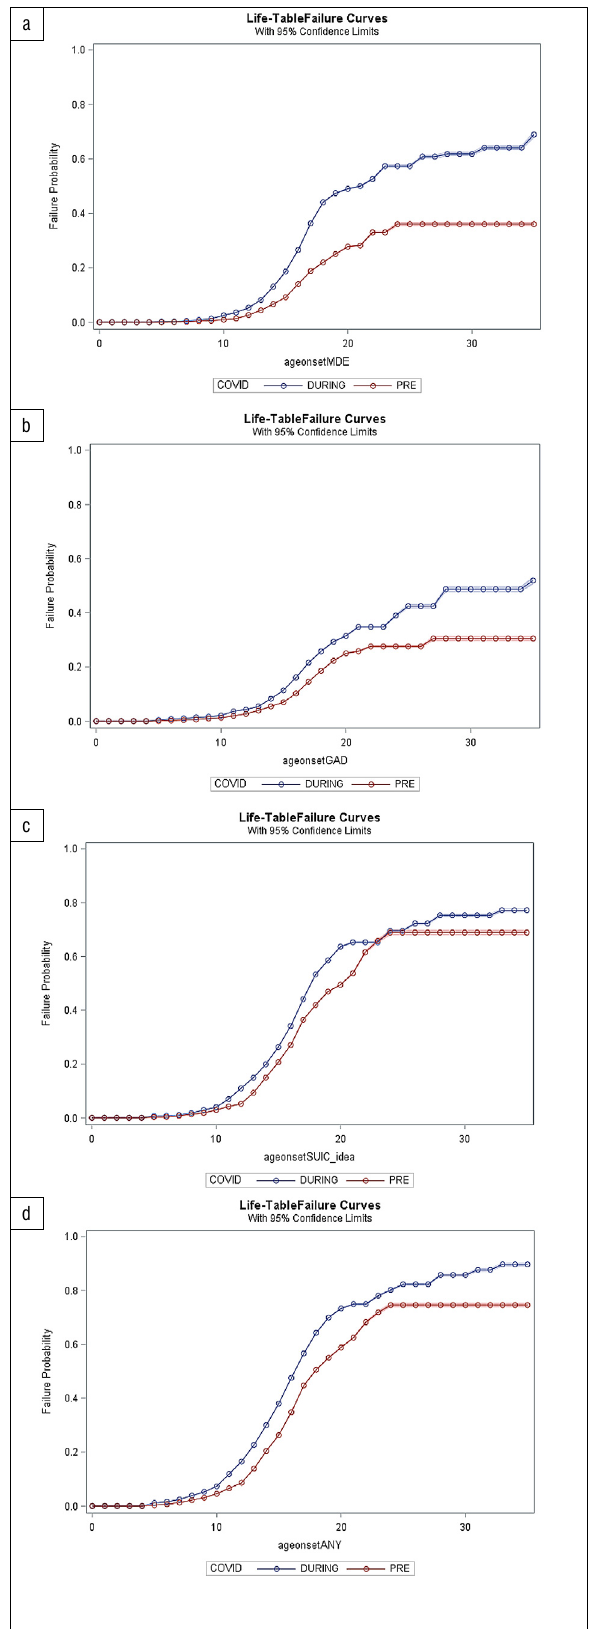
Figure 3: Age of onset curves up to age 24 for (a) major depressive episode (MDE), (b) generalised anxiety disorder (GAD), (c) suicidal ideation, and (d) any of these outcomes among first-year students at Stellenbosch University and University of Cape Town, before and after